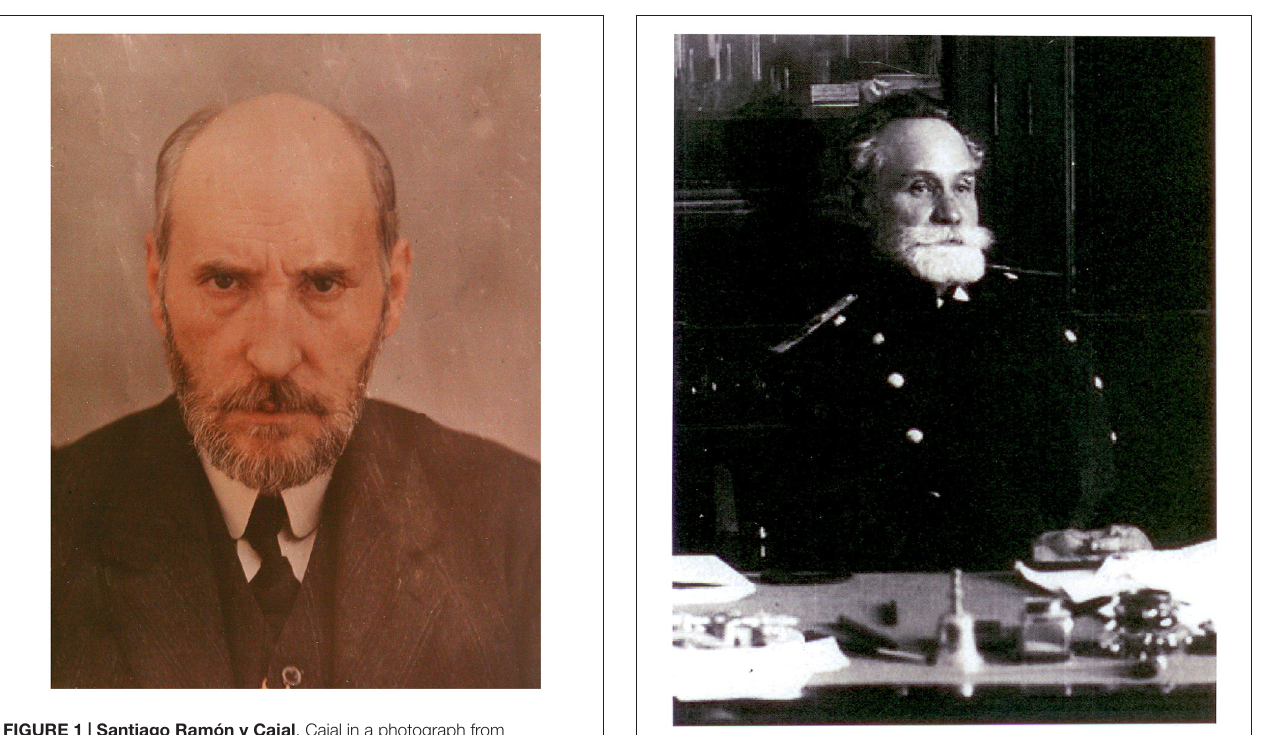
Medical Academy, St Petersburg in 1904, when he was awarded the Nobel Prize in Physiology or Medicine (image reproduced with permission from The Institute of Experimental Medicine of the Northwest Branch of the Russian Academy of Medical Sciences, St.